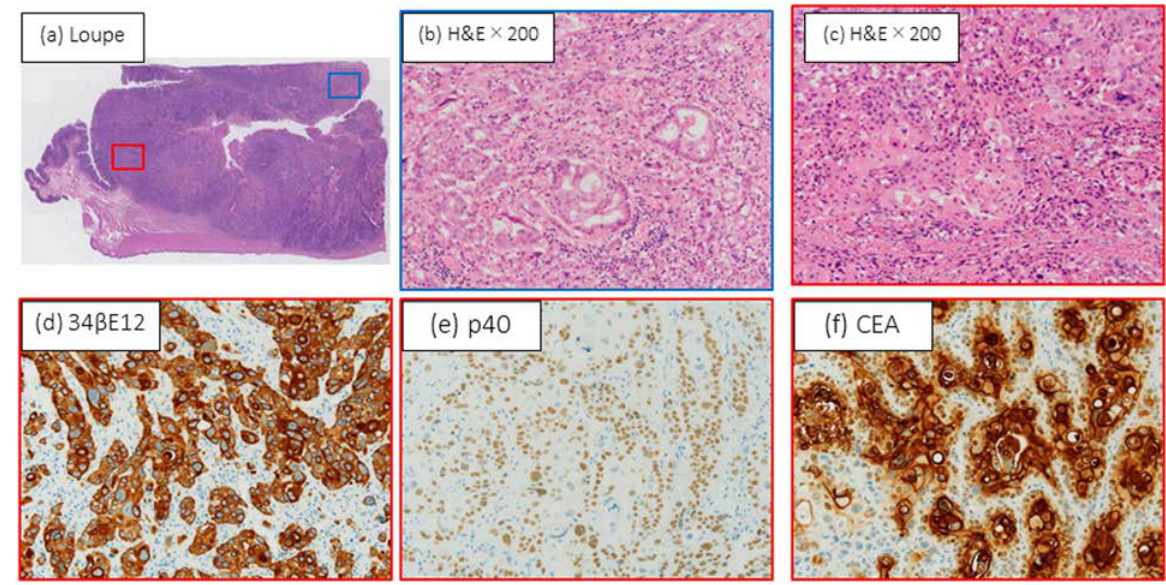
Figure 4 Microscopic and immunohistochemical features of adenosquamous carcinoma of the cecum. (a) Histological findings. Blue: adenocarcinoma (AD) component; red: squamous cell carcinoma (SCC) component (hematoxylin and eosin [H&E]; loupe). (b) Ductal and cribriform pattern of atypical columnar AD cells (H&E; 200× magnification). (c) Island pattern by dysplastic squamous epithelium with keratinization in SCC component (H&E; 200× magnification). Immunohistochemistry shows SCC component is (d) strongly 34 β E12+, (e) p40+, and (f) focally positive for carcinoembryonic